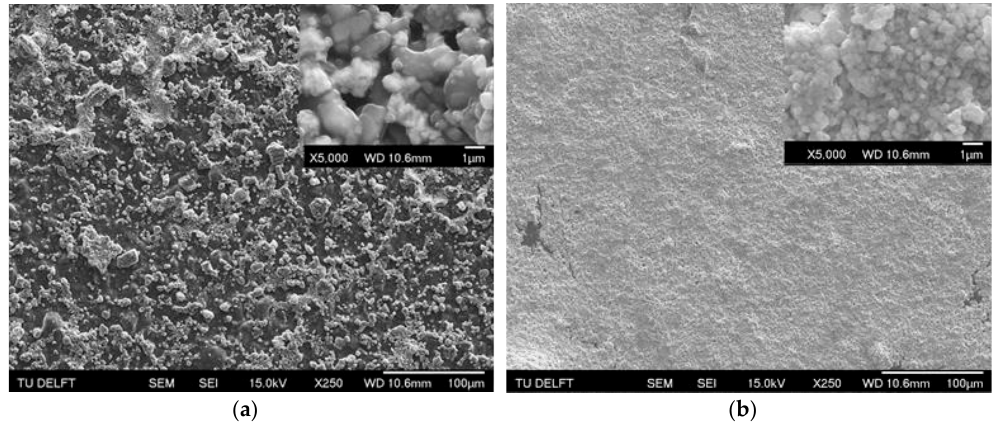
Figure 2. Scanning electron microscopy (SEM) images of the polishing waste samples: ( a ) sample A shows the coarser particles and ( b ) sample B shows the finer particles. Sample A is from plate glass polishing and sample B is from mirror polishing.